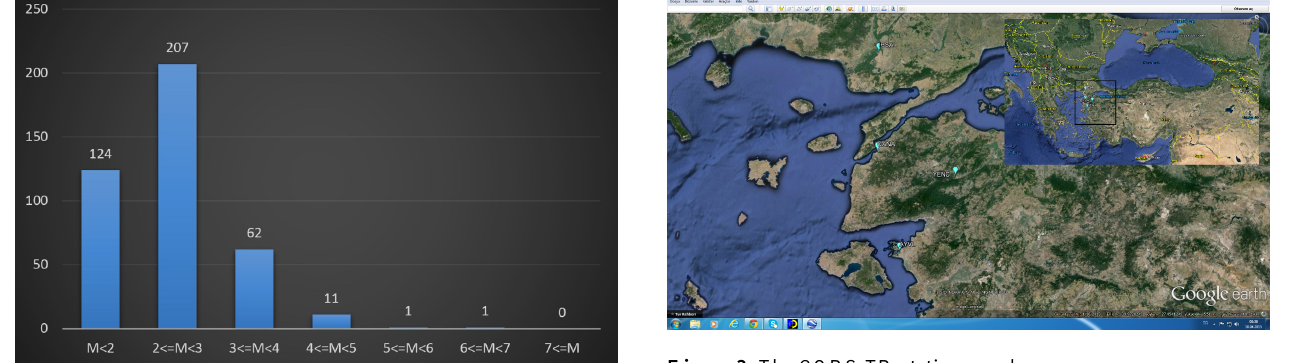
level during an earthquake possibility, which could occur in various countries, including Turkey (URL-1).